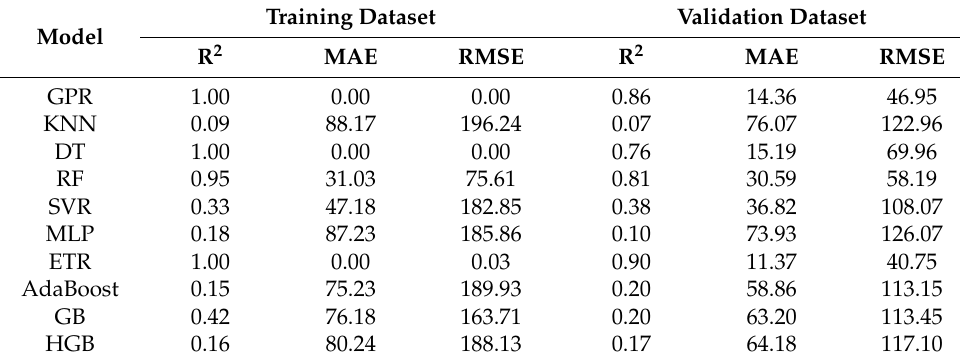
best performance (R 2 = 0.90, MAE = 11.37, RMSE = 40.75), followed by the GPR (R 2 = 0.86, MAE = 14.36, RMSE = 46.95) and the RF model (R 2 = 0.81, MAE = 30.59, RMSE = 58.19). The KNN (R 2 = 0.07, MAE = 76.07, RMSE = 122.96) and MLP (R 2 = 0.10, MAE = 73.93, RMSE = 126.07) performed poorly in predicting the condition status of the sewer